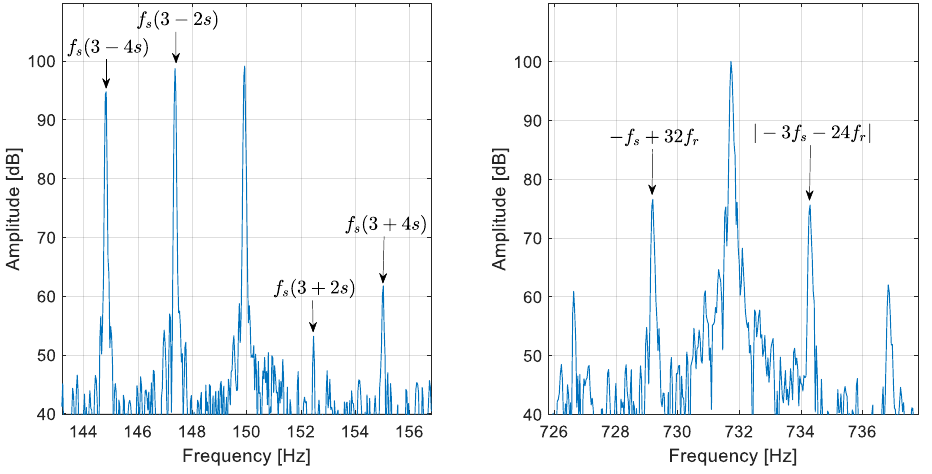
Figure 19. ZSC spectrum measured during laboratory tests of a motor with a wye connection and a